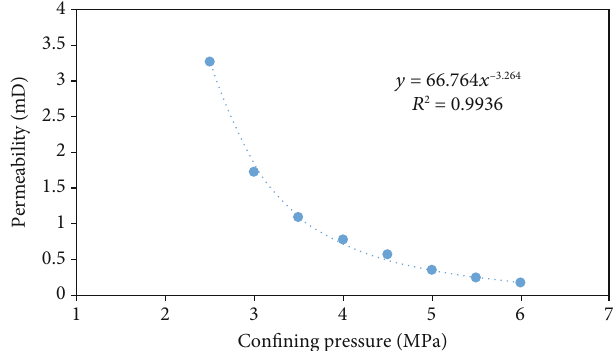
Figure 7: Dependence of sandstone permeability on con fi ning pressure.